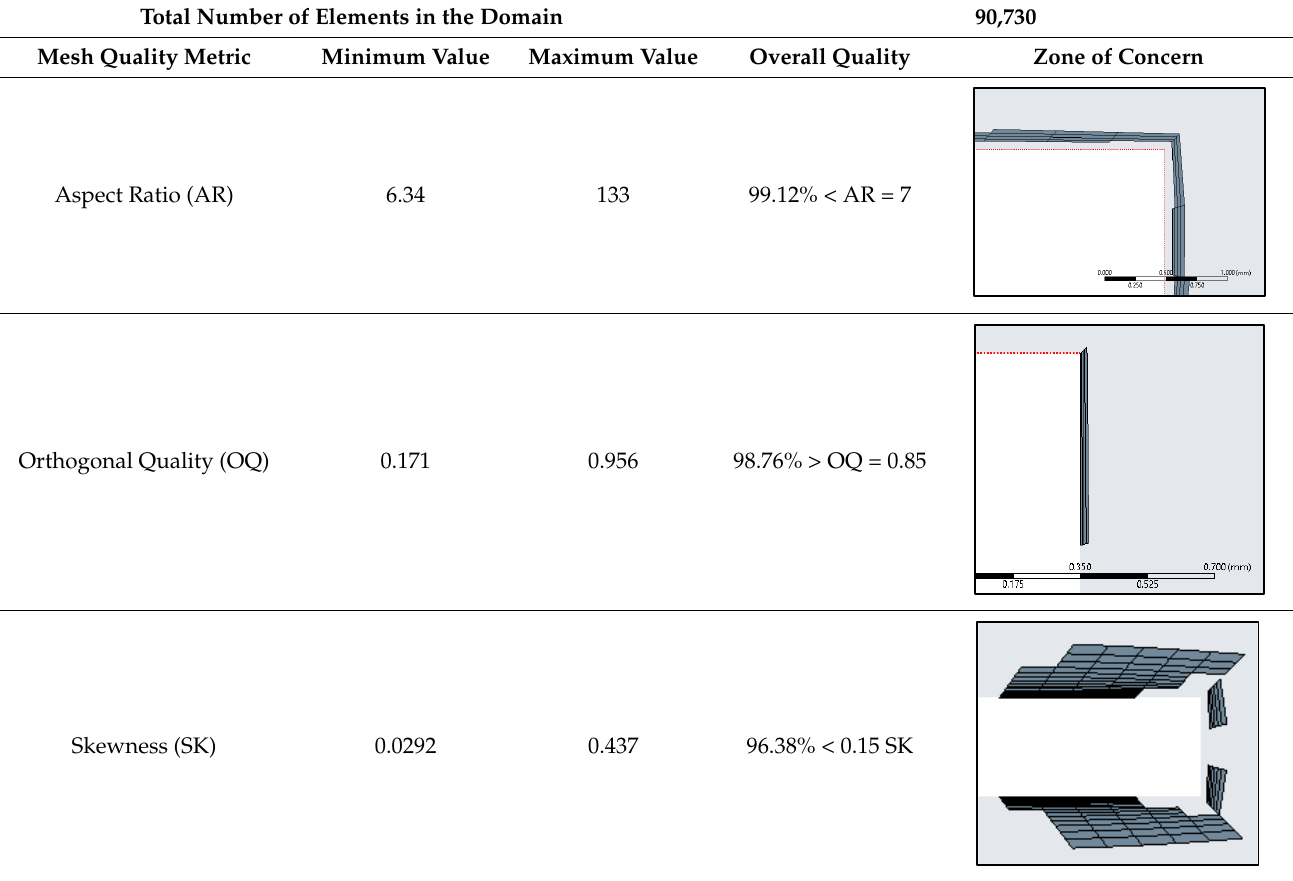
Table 1. Mesh quality metric evaluation. Figure 14. Local capsular discretization to capture the wake distribution of the separated flow.